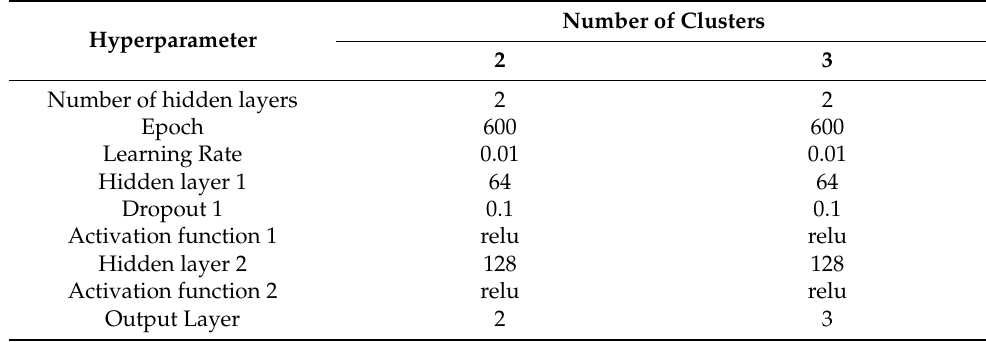
Figure 2. The feed-forward artificial neural network structure. Table 2. Hyperparameters for the feed-forward artificial neural